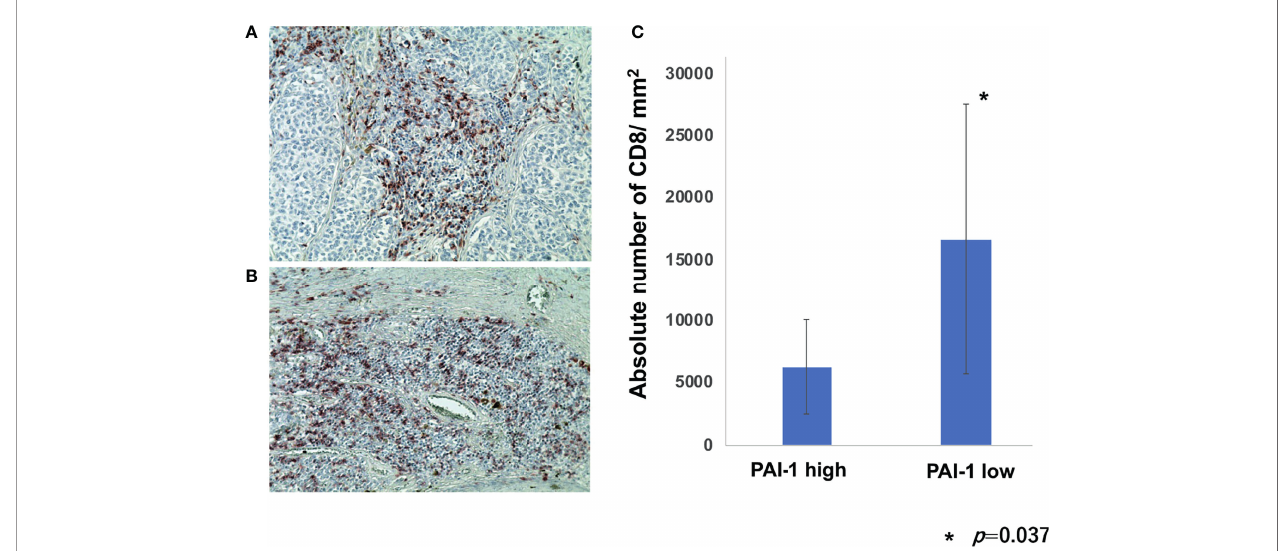
FIGURE 4 | Percentage of CD8+ cells per TILs in melanoma patients. Sections of melanoma from an anti-PD1 Abs in a high PAI-1 expression patient (A) and a low PAI-1 expression patient (B) were deparaf fi nized and stained using anti-CD8 antibodies. Sections were developed with liquid permanent red. The percentages of CD8+ cells per TILs were automatically counted by BZ-X800 (C)